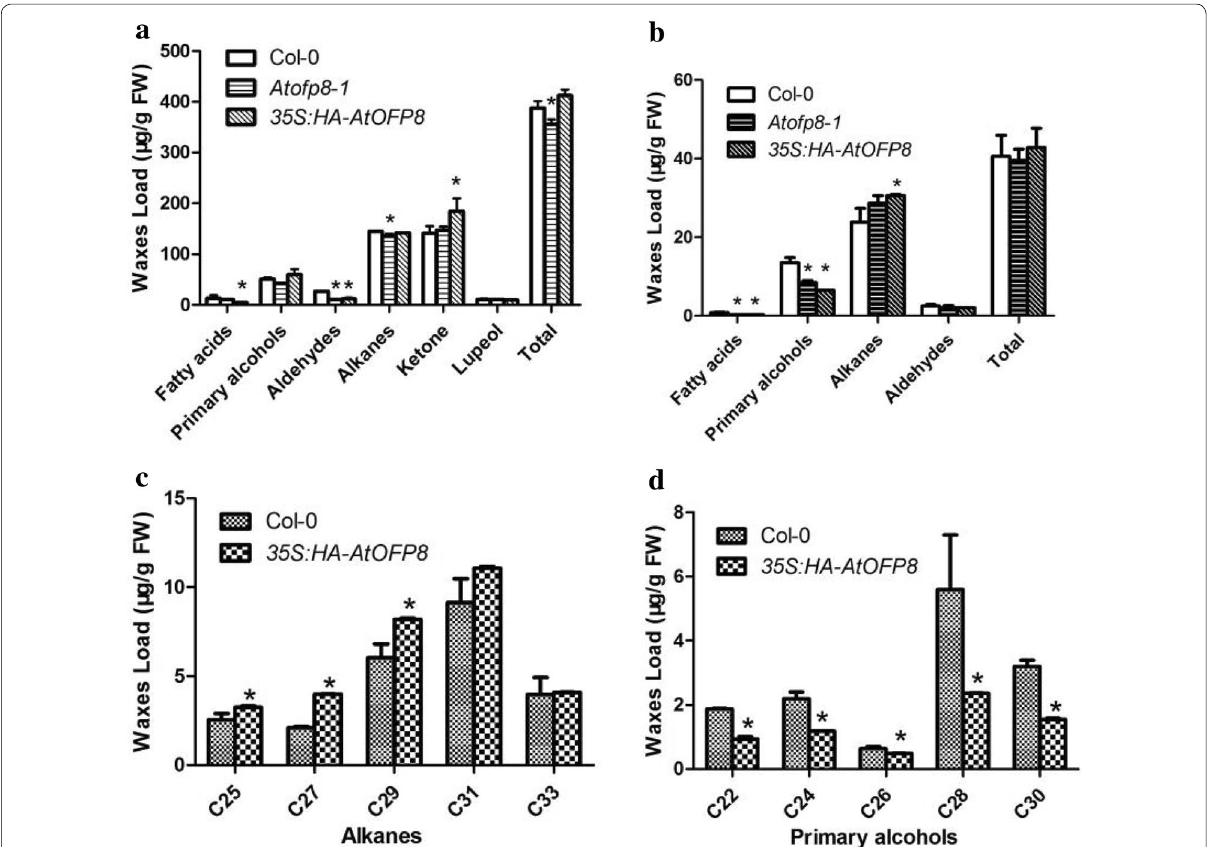
Fig. 4 Epicuticular waxes accumulation in the stems ( a ) and leaves ( b – d ). 5 weeks old stems and leaves were used. Biological triplicates, each with technical duplicates, were averaged. Statistical significance of the measurements was by comparing Col‑0 (*P < 0.05). Bars indicate SE of the mean. FW fresh